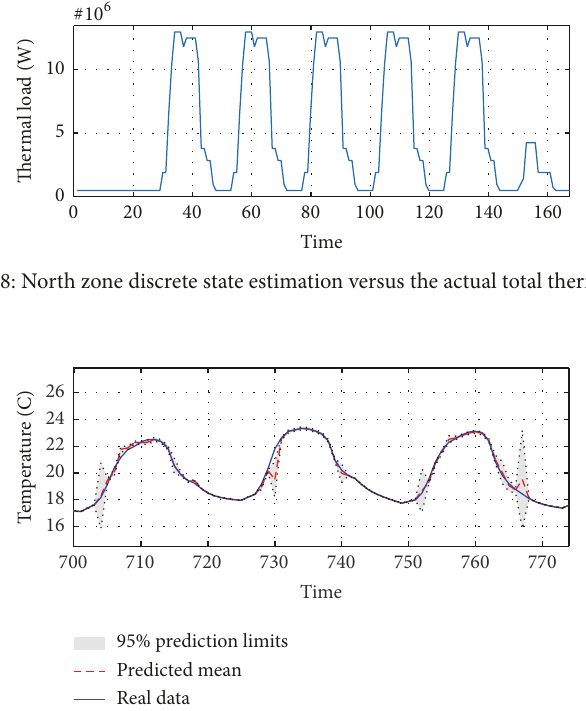
Figure 19: The predicted zone air temperature of the north zone.